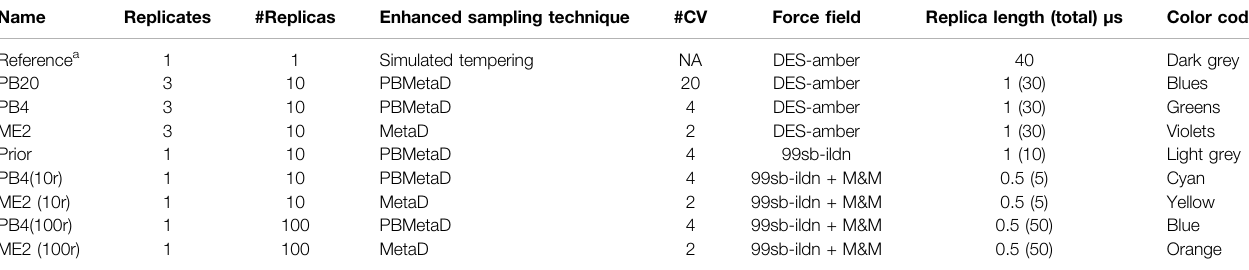
TABLE 1 | Summary of the simulations performed or analyzed in this